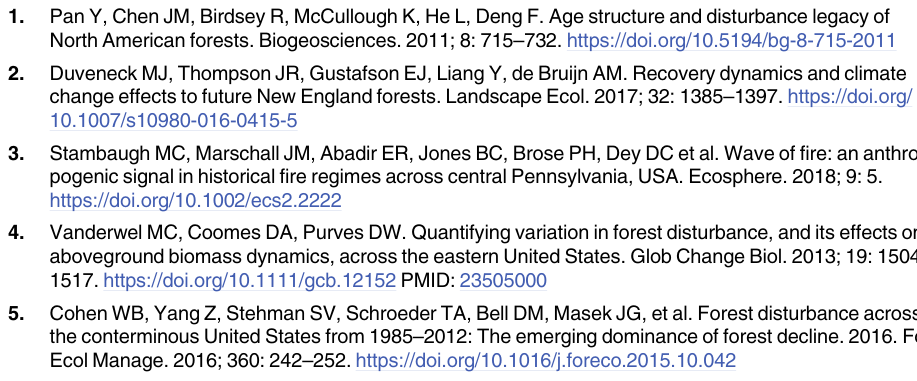
tested using ANOVAs and Tukey’s HSD tests, and values indicated with different superscripts among stands are significantly different. S3 Table. Structural characteristics of the canopy and understory in uninfested areas and areas infested by southern pine beetle. Values are means ± 1 SE. Significance levels were tested using paired sample T-tests, and values indicated with different superscripts among areas are significantly different. S4 Table. Meteorological sensors and eddy covariance equipment used to measure turbu- lence, net ecosystem exchange of CO (NEE) and evapotranspiration (Et) at the oak, mixed 2 and pine